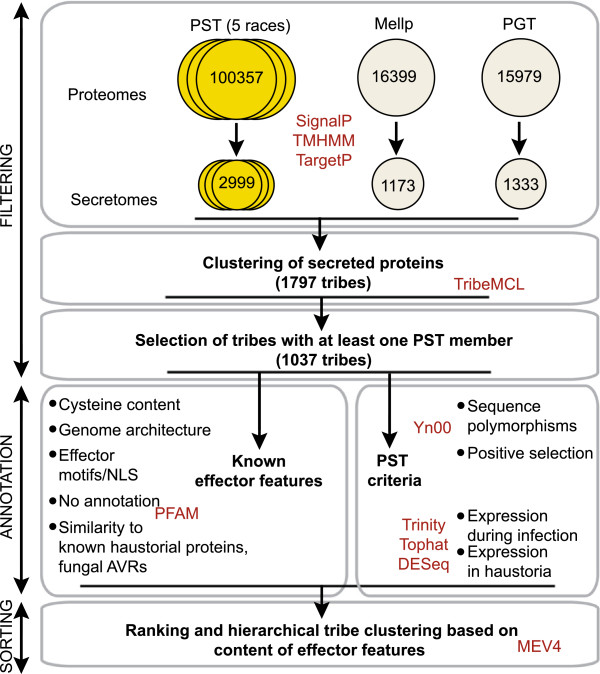
Clustering of secreted proteins and annotation of protein tribes based on known effector features and PST-specific criteria. A bioinformatic pipeline was implemented to identify groups of secreted proteins with characteristic effector features. The proteomes of the five PST isolates were combined (totaling 100357 proteins), 5502 secreted proteins predicted, and redundancy reduced. The consolidated PST secretome (2999 proteins) was combined with predicted secretomes from P. graminis f. sp. tritici (PGT) and Melampsora larcia populina (Mellp) and proteins grouped based on sequence similarity (Markov clustering). Tribes containing at least one PST member (1037 tribes) were annotated with known effector features or PST-specific criteria. Finally, tribes were ranked and heirarchical clustering implemented based on their content of proteins with known effector features. Programs are indicated in red. NLS, nuclear localization signal.